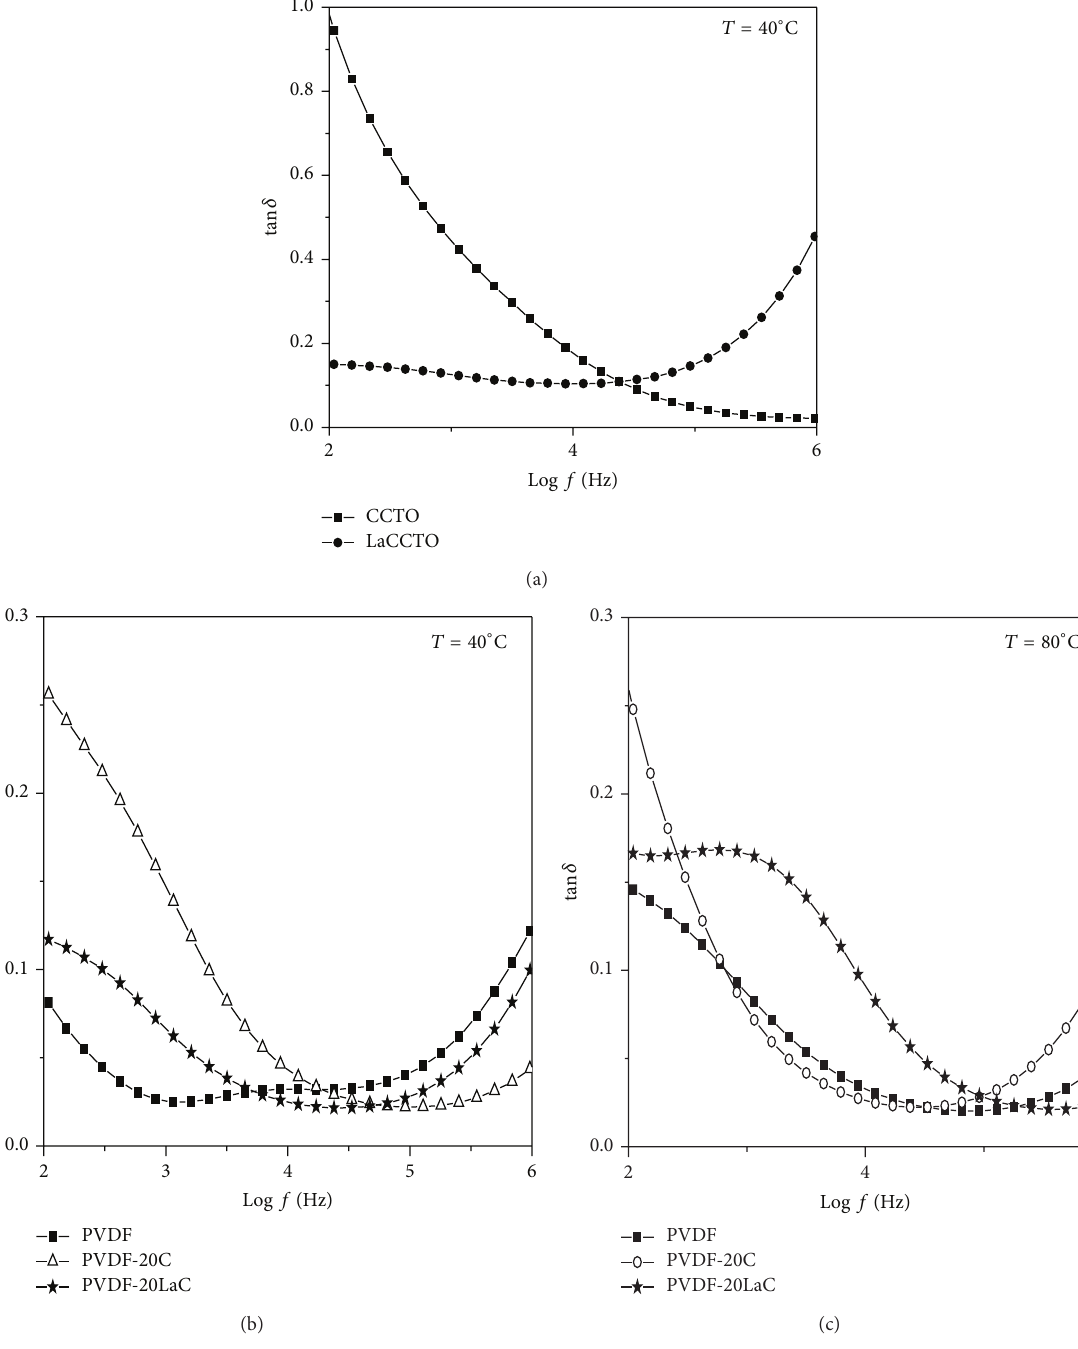
Figure 5: Frequency dependence of loss tangent of CCTO and LaCCTO (a), PVDF, PVDF-20C, and PVDF-20LaC composites at 40 ∘ C (b) and 80 ∘ C